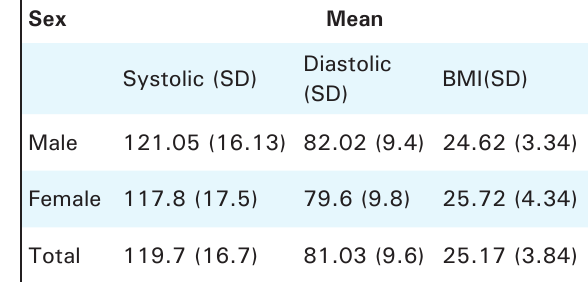
Table 4. Mean blood pressure according to sex.